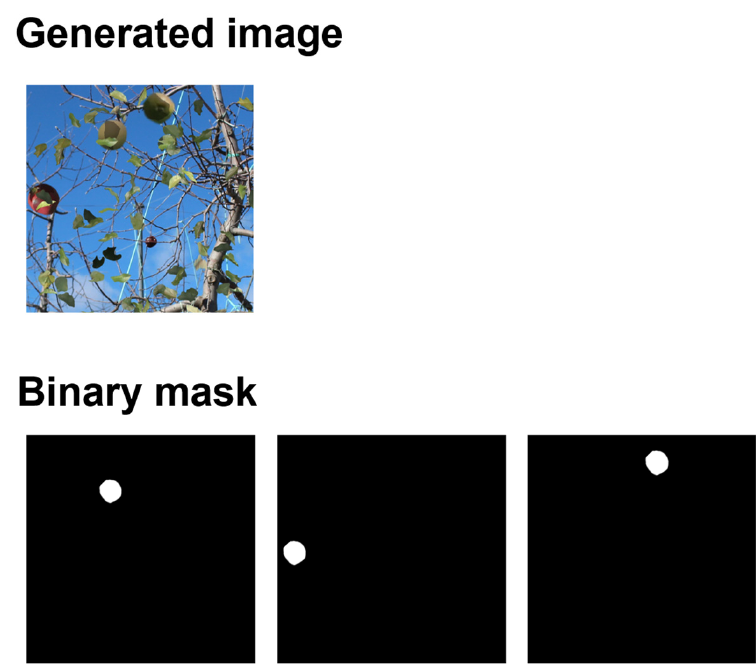
Figure 4. Binary mask and generated image. Each fruit is placed at the white position in the binary mask, respectively.